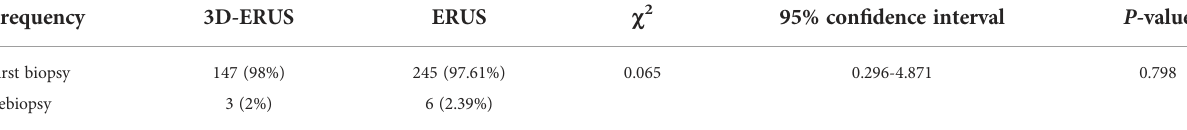
TABLE 11 Comparison of rebiopsy rate between 3D-ERUS group and ERUS